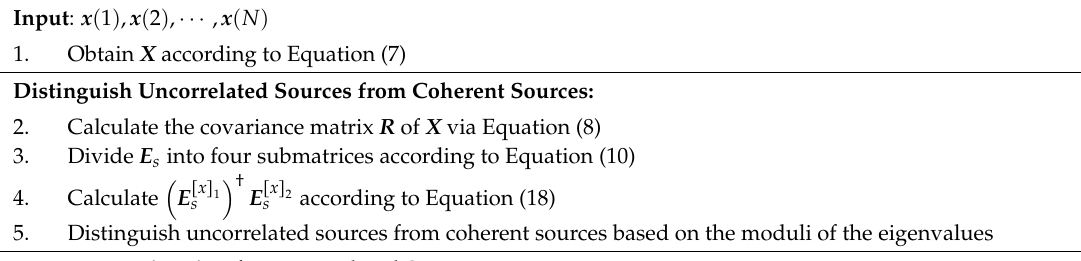
Table 2. The main steps of the proposed